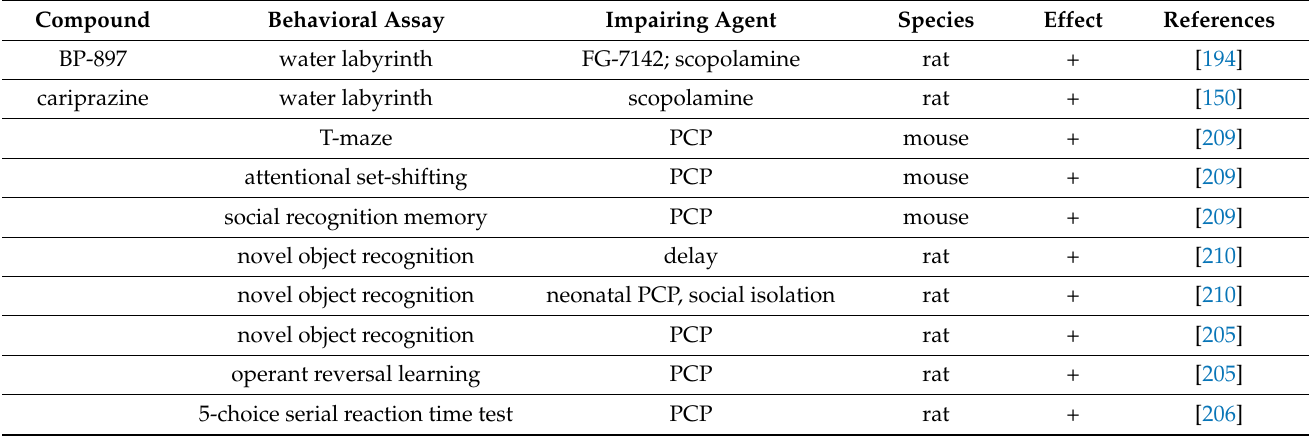
Table 4. Cognitive effects of D3R preferring partial